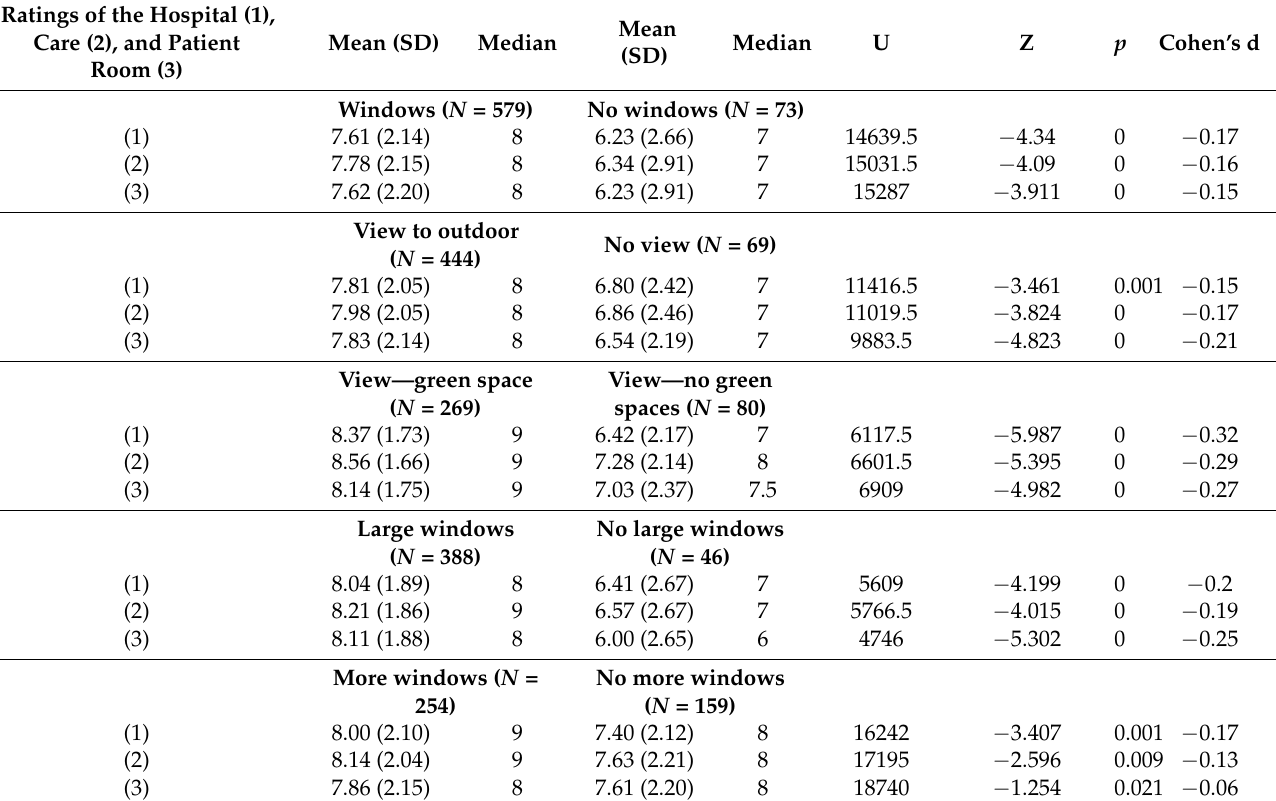
Table 3. Results of the Mann–Whitney U test for windows, view from bed, view content, window size, and quantity. Ratings of the Hospital